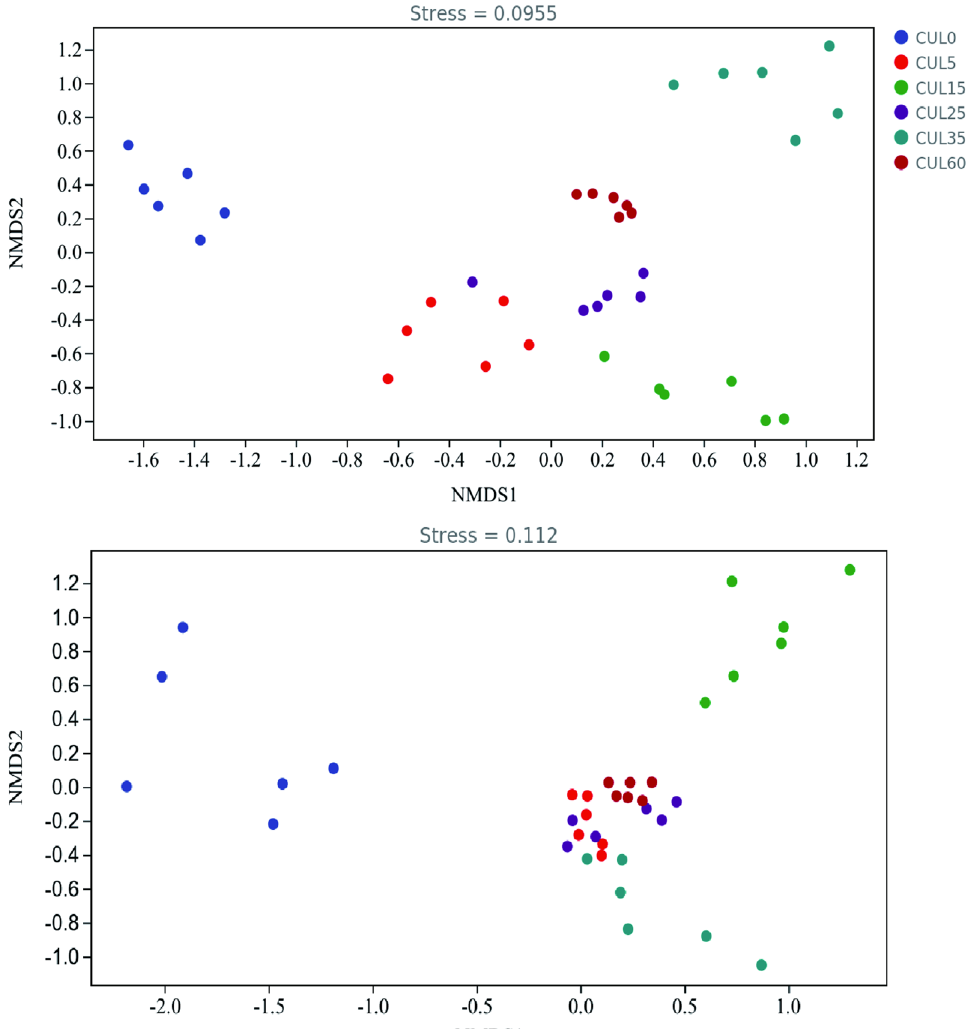
Fig. 3 Dissimilarity of soil microbial communities shown by nonmetric multidimensional scaling (NMDS): A bacteria and B